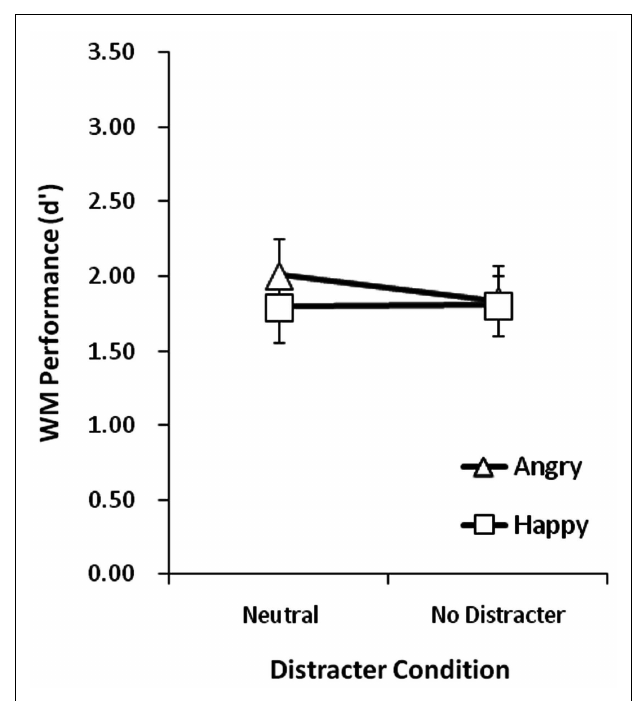
FIGURE 2 | Group meanWM performance measured in d (cid:48) when allWM memoranda faces had happy or angry expressions and either neutral words or no-distracter were presented during the retention interval. Vertical lines represent ± 1 SE.